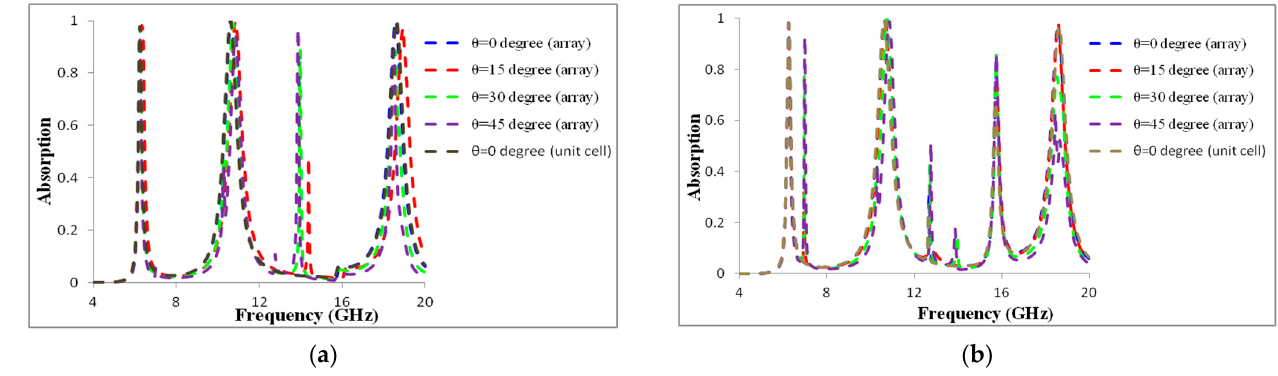
Figure 12. Absorption at ( a ) TE and ( b ) TM mode for a 2 × 2 array and unit cell.